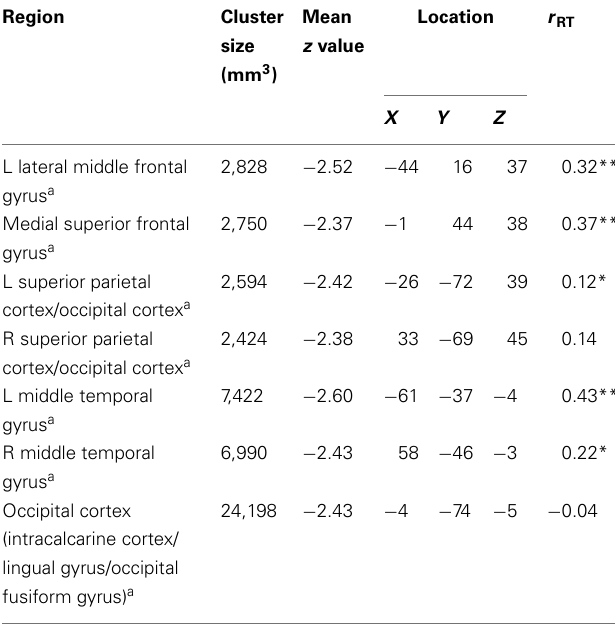
Table 3 | Brain areas with interactive effects for trait and state negative affect and correlations with